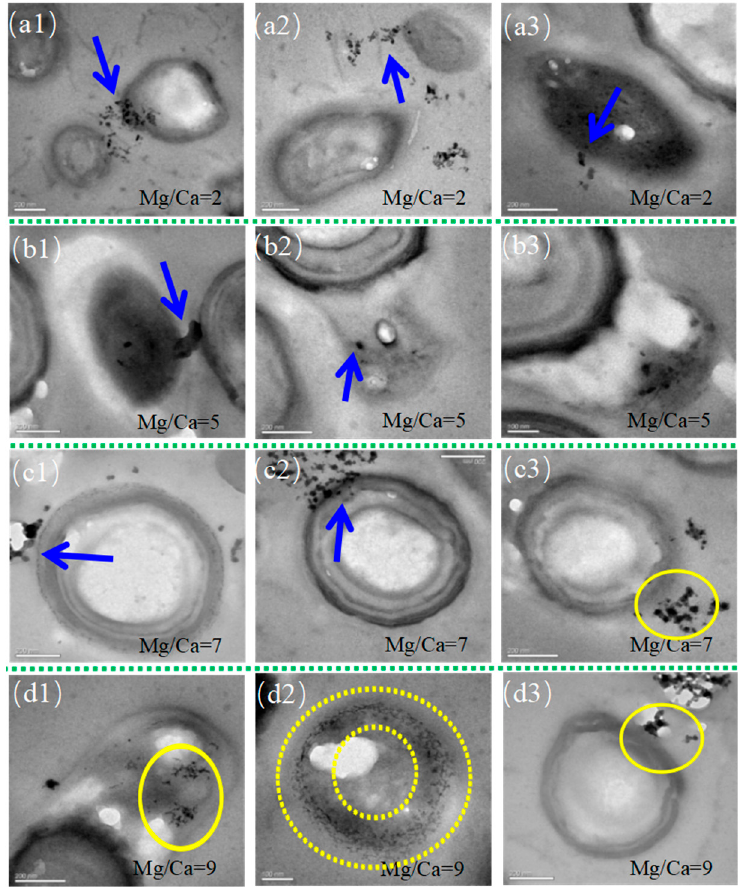
Figure 11. HRTEM analyses of biomineralization on the cell surface / EPS of H. smyrnensis WMS-3 bacteria at Mg / Ca molar ratios 2, 5, 7, and 9 ( a1–3, b1–3, c1–3 , and d1–3 ), respectively. (The blue arrows and yellow circles represent the location of minerals.)